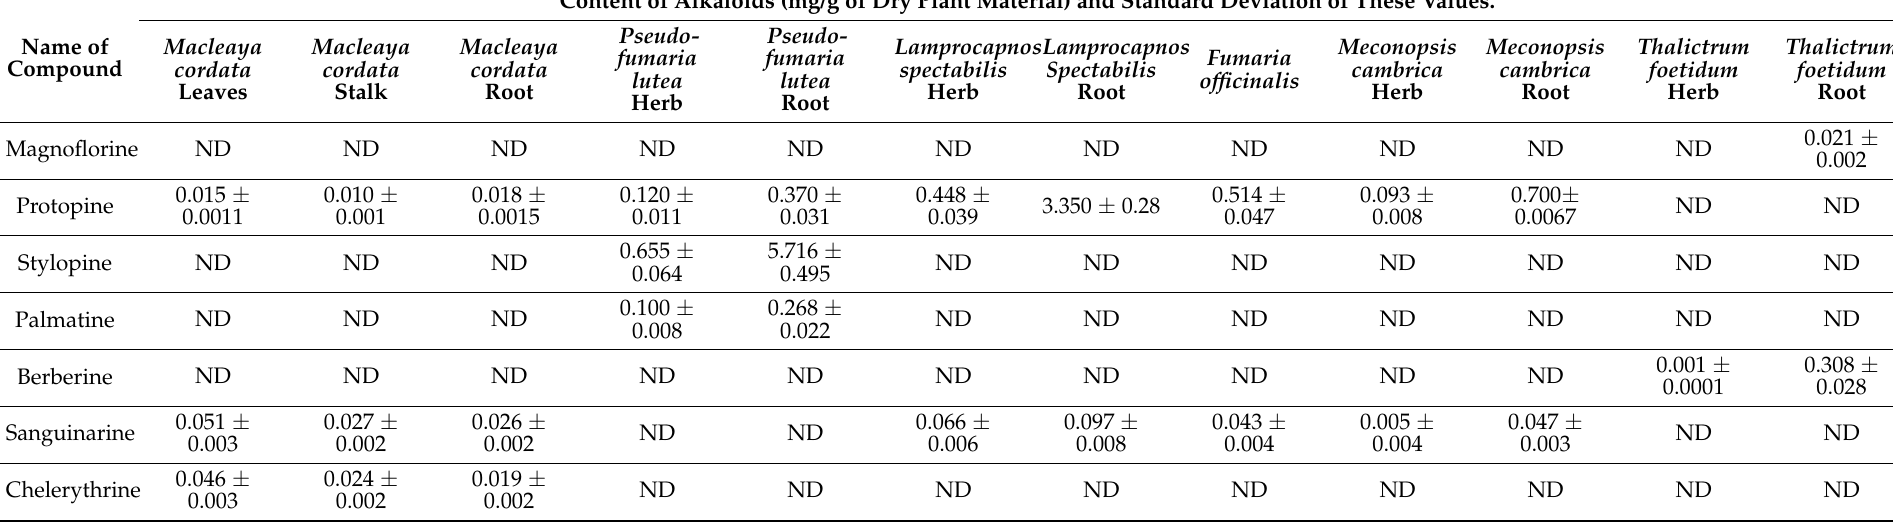
Table 4. Content of alkaloids in plant